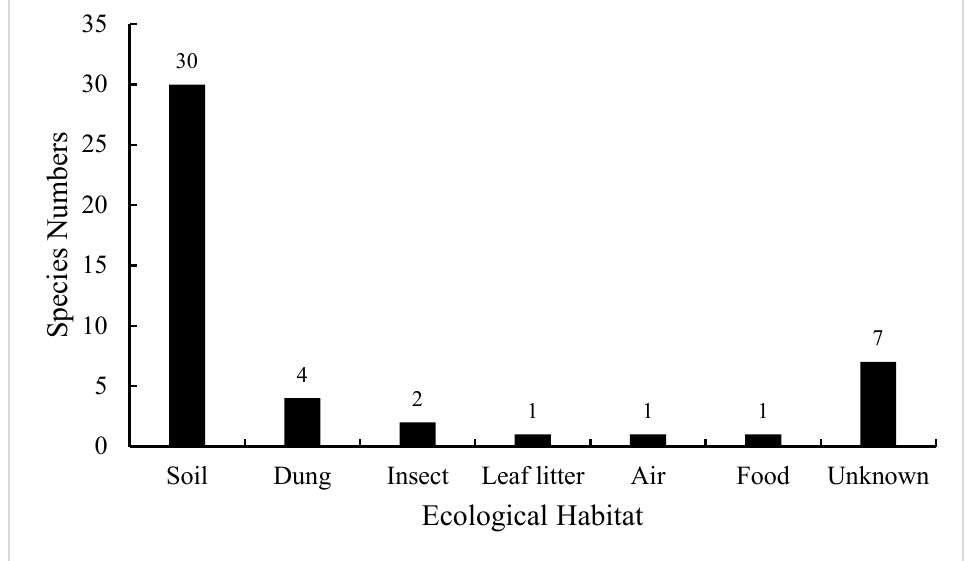
Figure 1. Number of Absidia species in different ecological habitats when they were originally described. These data are from the Index Fungorum (http://www.indexfungorum.org/, accessed on 1 March 2022) and [16].